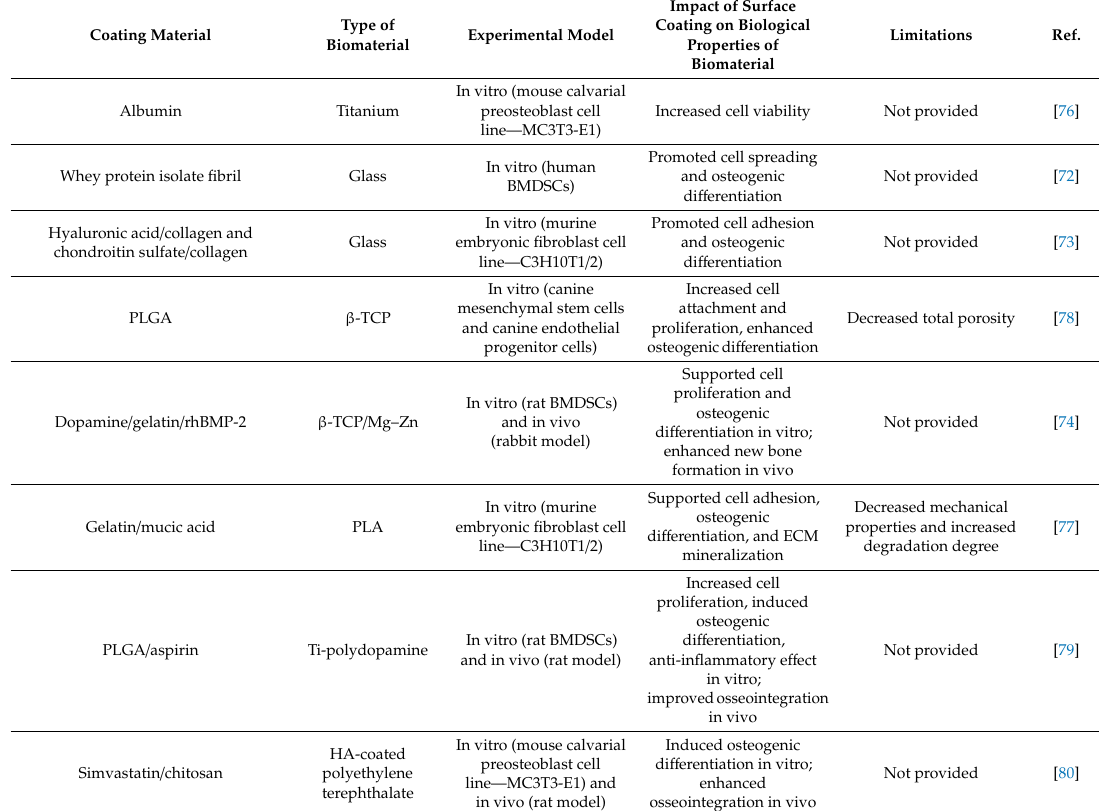
Table 2. Surface modifications of biomaterials using organic